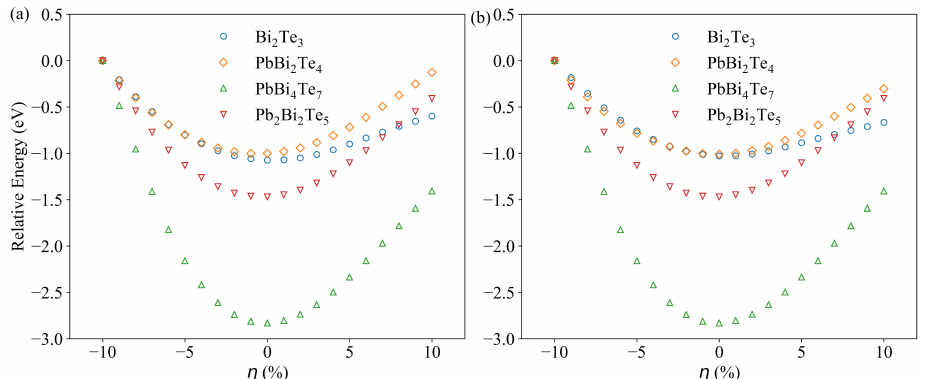
Figure 3. Evolution of the relative total energy as a function of strain without ( a ) and with SOC ( b ). The reference energy is taken as the energy of the structures under 10% compressive